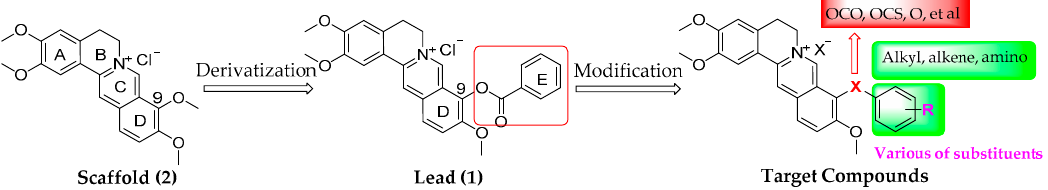
Figure 1. Chemical structures of 1 , palmatine Scaffold 2 and structural modification strategy.